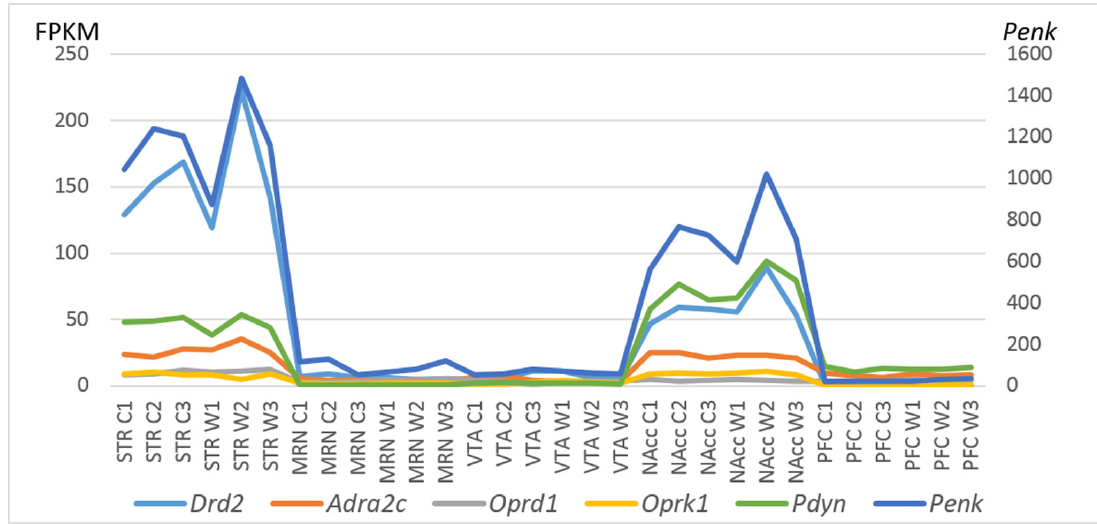
Figure 7. FPKM values of five CAergic- and opioid-specific DEGs across 30 samples on the basis of the included RNA-Seq FPKM data for five brain regions. C1, C2, and C3: controls; W1, W2, and W3: winners; VTA: ventral tegmental area, NAcc: nucleus accumbens, MRN: midbrain raphe nuclei, STR: dorsal striatum, and PFC: prefrontal cortex.